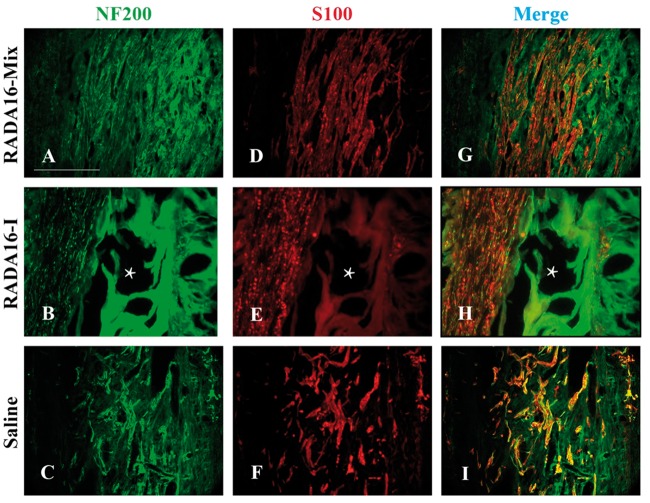
The longitudinal sections of the middle position 12 weeks after implanting different grafts. The axons were labeled by NF200 in green and Schwann cells were labeled by S100 in red. The * shows the large cavity formed inside the RADA16-I graft. Scale bar: 200 μm.